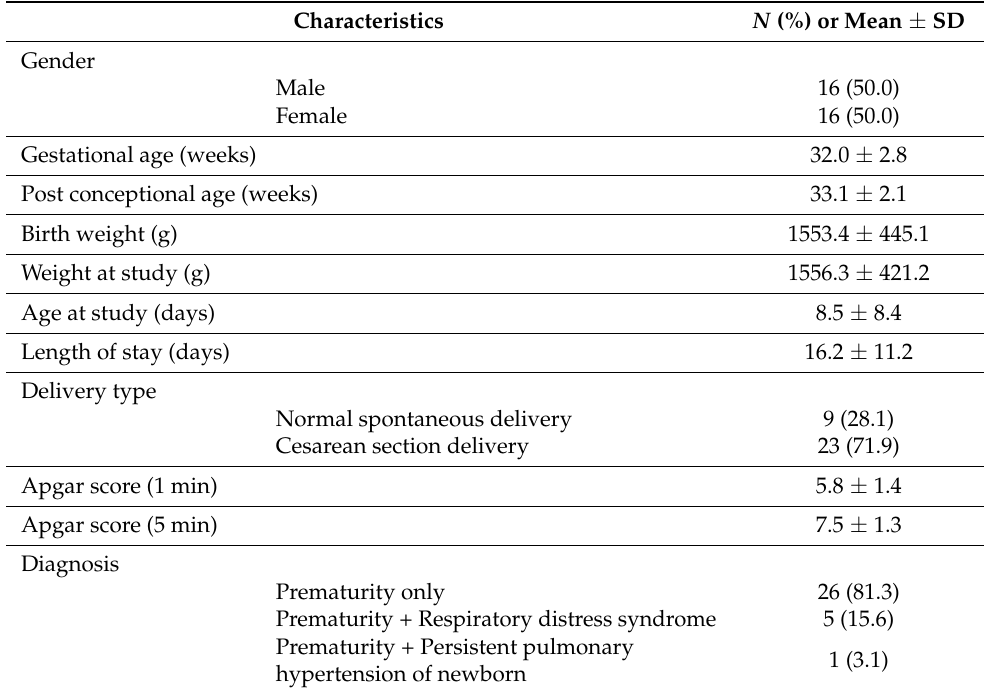
Table 1. General characteristics of participants (N = 32).